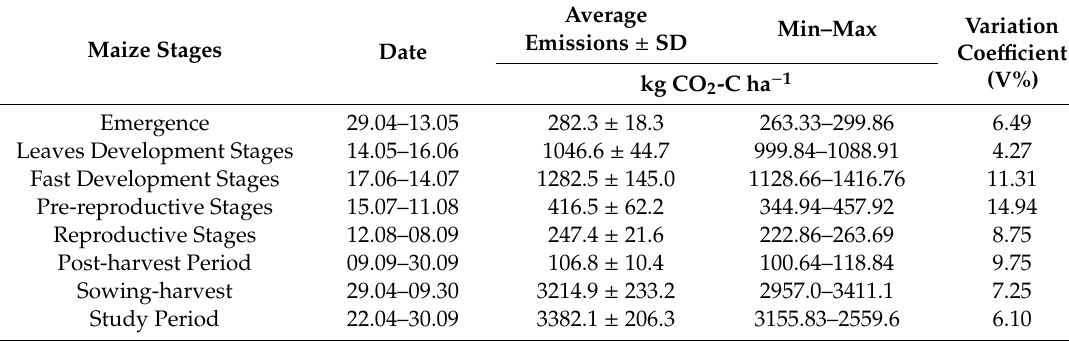
Cumulative CO 2 -C soil emissions during essential stages of growing maize season (sowing–harvest) and study